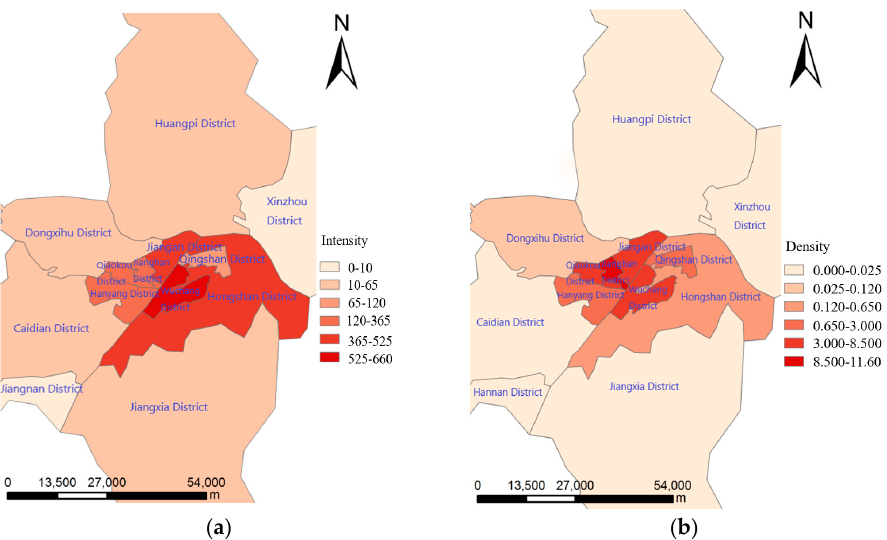
Figure 10. Spatial distribution of parking locations for taxi-driver shift events in each administrative district. ( a ) The intensity of taxi-driver shift events distributed in each administrative district of Wuhan. ( b ) The density of taxi-driver shift events distributed in each administrative district of Wuhan.